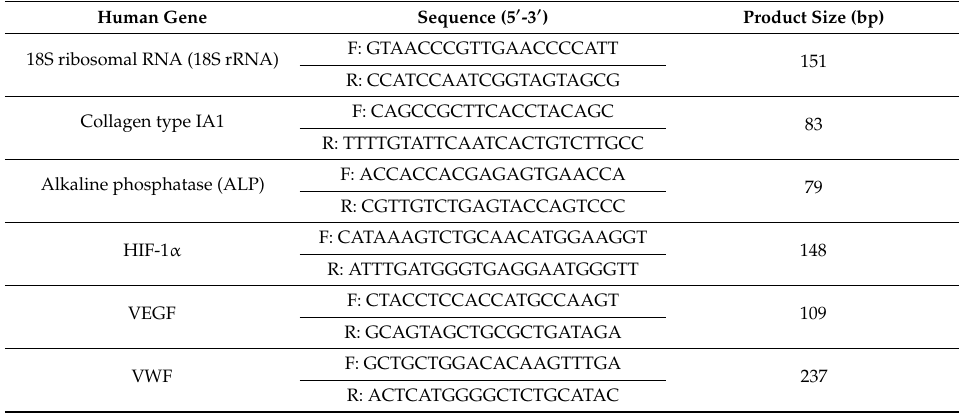
Table 1. Primer sequences for qPCR (F / R: forward /